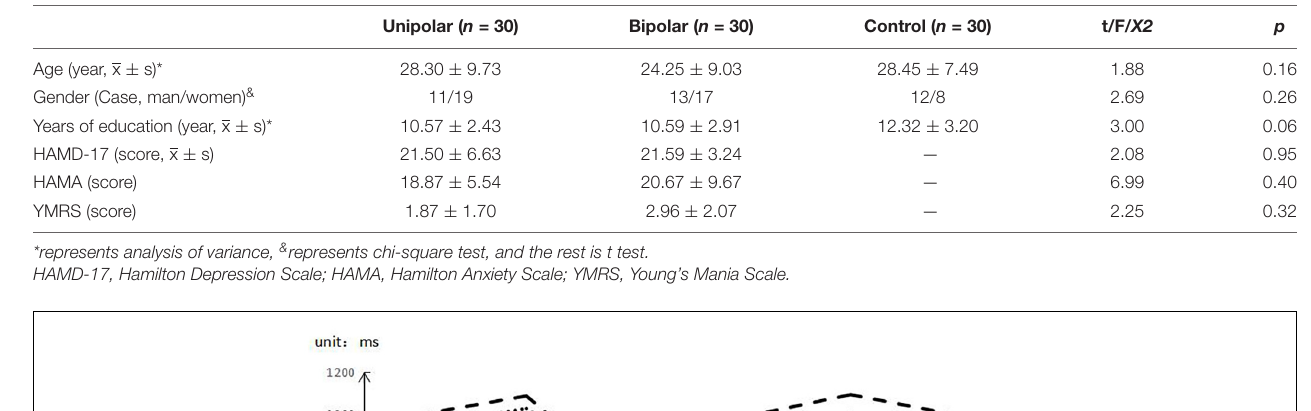
TABLE 1 | Comparison of general demographic data and clinical symptom scores ( x ± s).